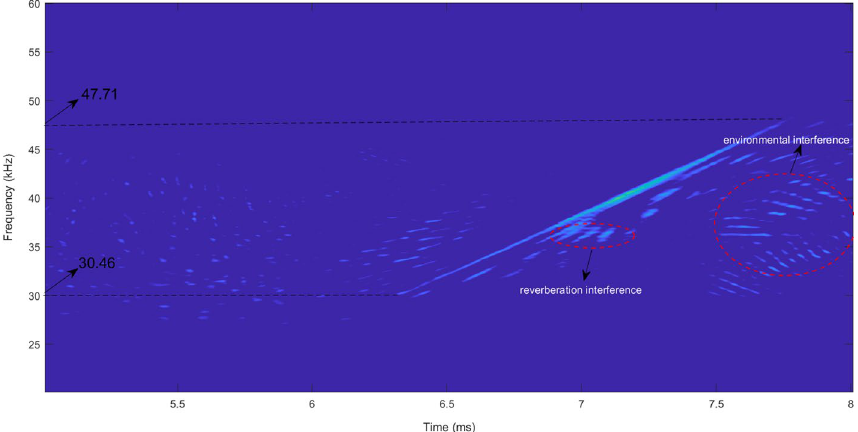
Fig. 10 Time–frequency distribution of observed reverberation signal with traditional WVD